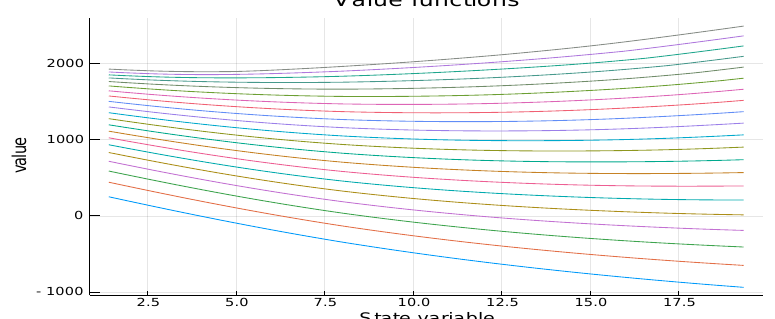
Figure 6. Value functions at t = 0 under optimal policies. Each curve corresponds to a battery level p 0 ∈ P : the lowest curve is associated with the lowest battery level, 0, the second lowest curve is associated with the second lowest battery level, 8, and so on. Each curve is drawn with respect to ( 2 ) a range of values for the state variable Z . The graphs are drawn with costs of deep discharge 0 ( η 1 = 100 and η 2 =